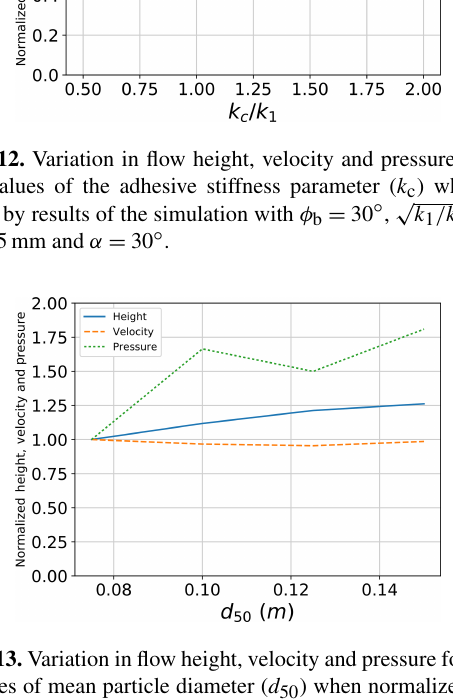
√ k 1 /k 2 = 0 . 3, d 50 = 75mm